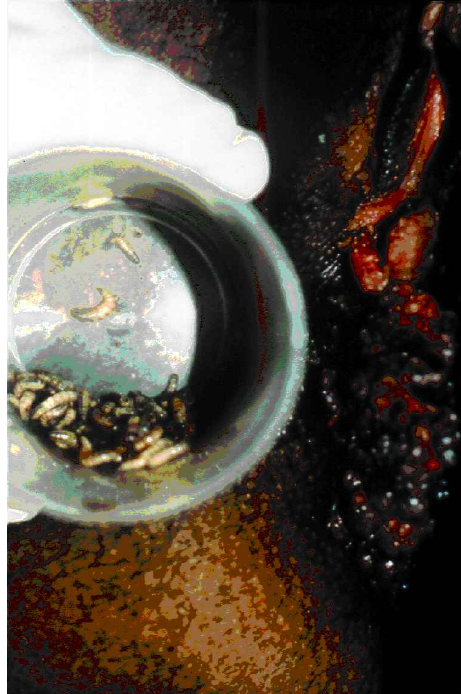
Figure 5 Case 2; larvae typical of Cochliomyia hominivorax